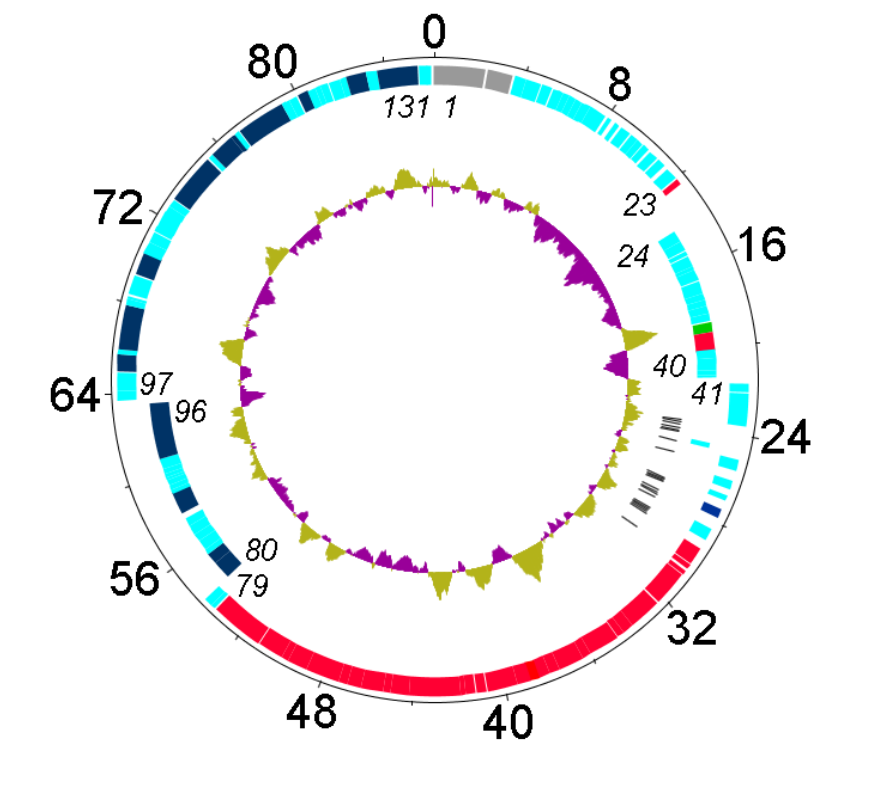
Figure 1 . Genetic and physical map of phage Felix O1 prepared using DNAPlotter [20] with, from outer to inner rings, the size in kb; genes on the forward and reverse strands with some of the genes listed in italics (N.B. gene 1 = rIIA ), and tRNA-encoding genes (black). The inner circles correspond to a GC plot (purple, below average GC-content; greenish-brown) and a GC skew analysis. Genes involved in nucleotide metabolism or DNA replication are indicated in dark blue, those involved in DNA packaging and morphogenesis in red; and, the lysis gene in dark